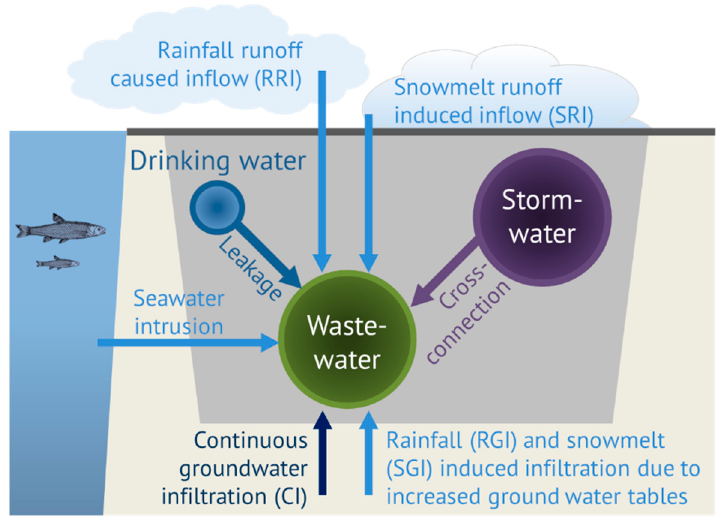
Figure 2. Pathways of I/I into foul sewers.